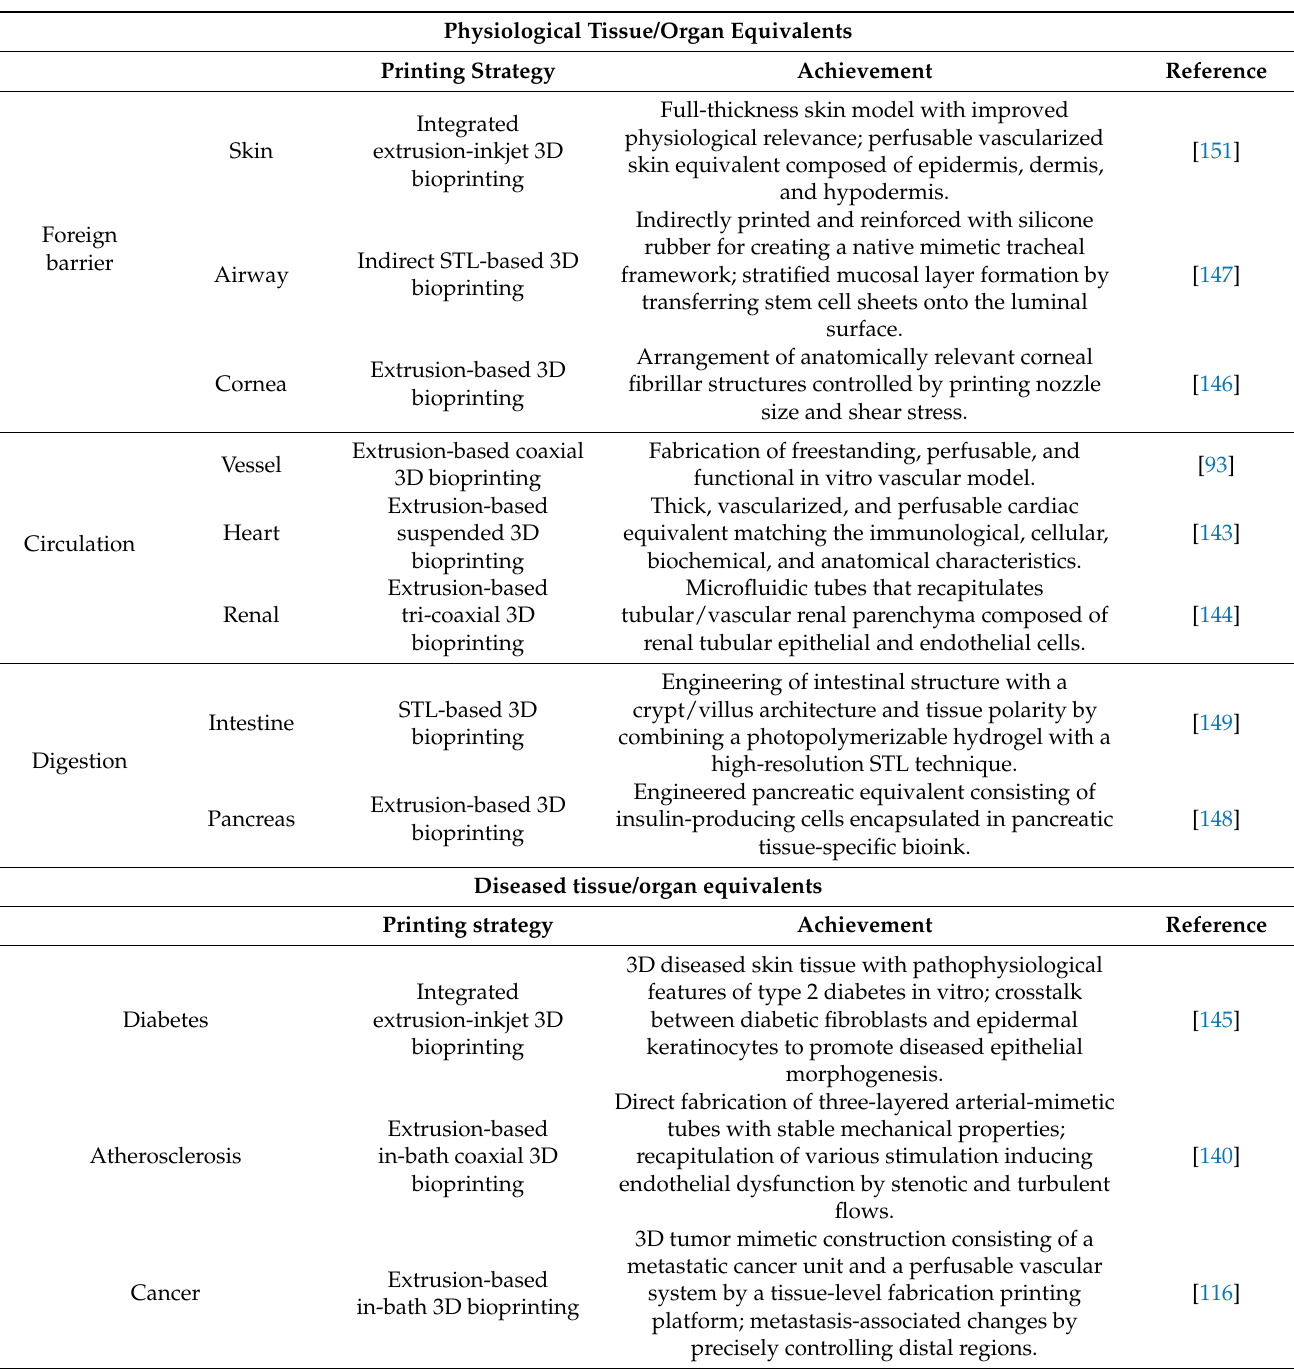
Table 1. Representative pharmaceutic applications of 3D bioprinted tissue/organ